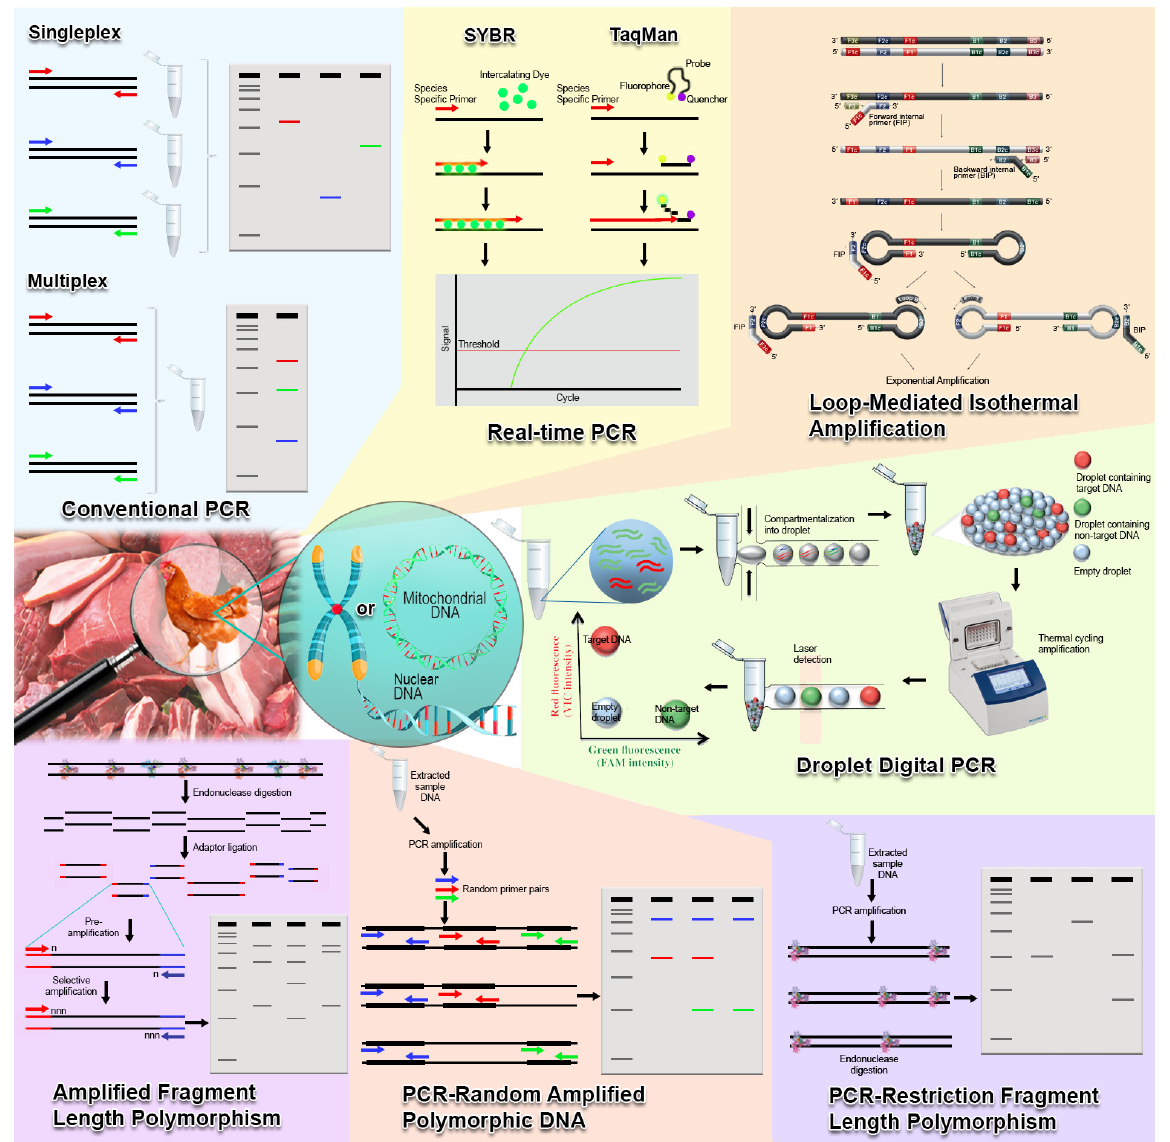
Figure 1. An infographic overview for classical DNA-based molecular techniques in chicken meat adulteration detection, species, and breeds identification. Conventional PCR can be performed to identify a species at a time (singleplex) or multiple species simultaneously (multiplex) using species-specific primer targeting either nuclear or mitochondrial DNA. Real-time PCR plays the same concept as conventional PCR but incorporating dyes to monitor the PCR product in real-time. Loop-mediated isothermal amplification amplifies the target species using a set of four to six specially designed primers under isothermal conditions. Droplet Digital PCR allows the detection of a very low number of targets in DNA mixture by fractionating samples into 20,000 droplets, followed by target amplification of target in each droplet and detection using a laser. PCR-RFLP amplifies a conserved DNA region followed by digestion of the PCR products using one or more restriction endonucleases. Restriction profile can be obtained from the variation in band formation from agarose gel electrophoresis. PCR-Random Amplified Polymorphic DNA amplifies random segments of DNA by PCR using a single arbitrary primer binds to different loci in different species; variation in band patterns can be used to discriminate species. Amplified fragment length polymorphism technique discriminates individual species or breeds based on the selective PCR amplification of restriction fragments caused by single nucleotide polymorphism from a total digest of genomic